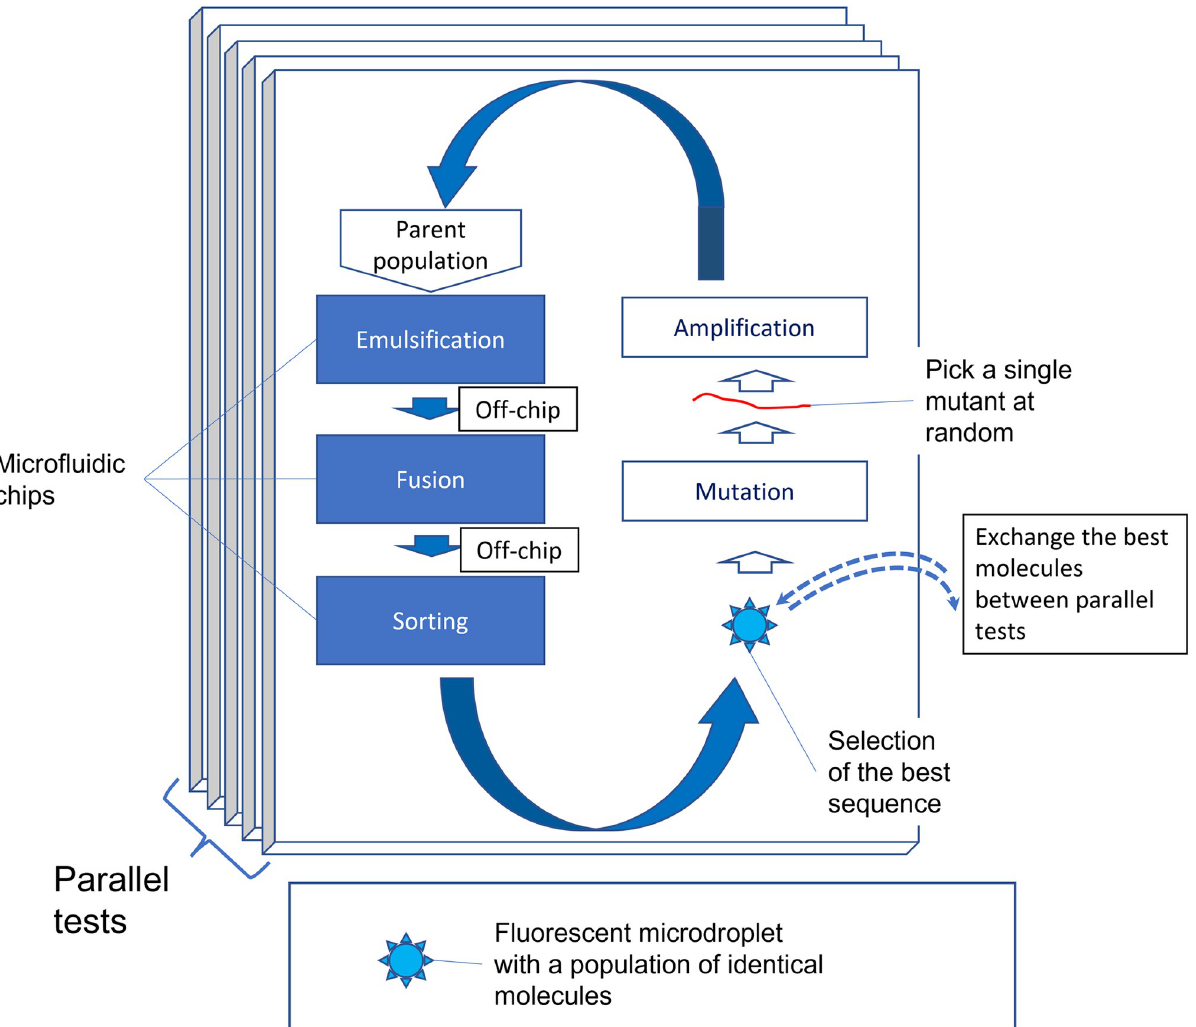
Fig 10. Block diagram of the experimental setup. Block diagram of the experimental setup of the experimental setup for the implementation of parallel RMHCs in the experiment. Includes several experiments organized and running in